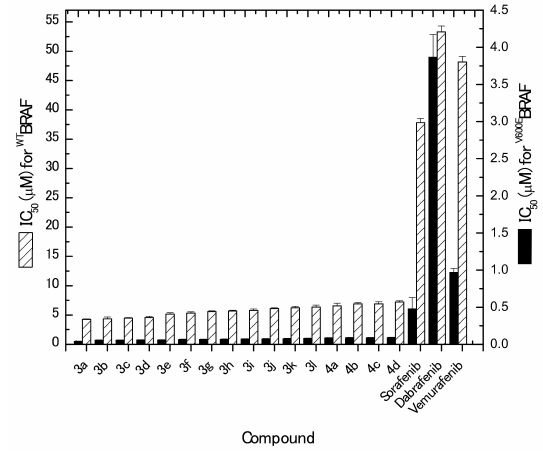
Figure 4. IC 50 values of synthesized for both WT BRAF and V600E